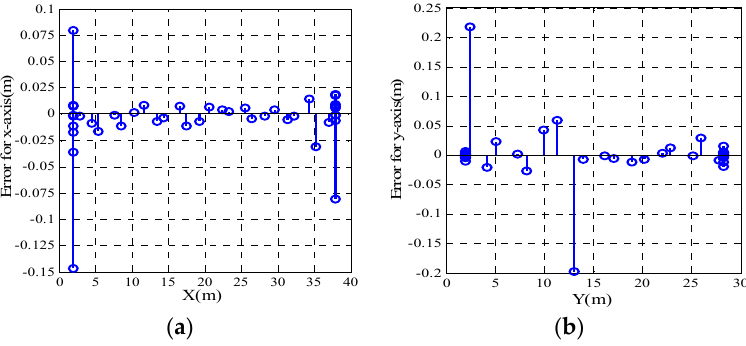
Figure 24. Elderly fall location errors at NLOS environments for ( a ) x-axis and ( b ) y-axis .